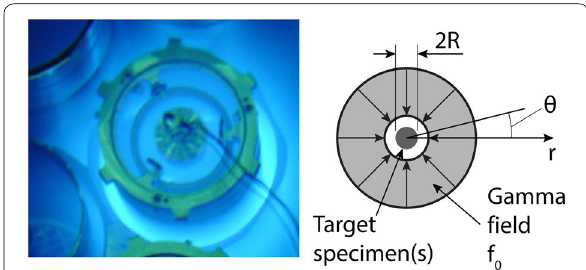
Fig. 1 Irradiation setup with cylindrical symmetry. Photograph of the gamma irradiation facility at the High Flux Isotope Reactor courtesy of Oak Ridge National Laboratory. Specimens are not directly exposed to water, but are housed inside the irradiation chamber in the middle of the fuel source, and are in direct contact with a purge gas (typically nitrogen) and thermal equilibrium is maintained by radiative heat transfer between the specimens and the chamber.